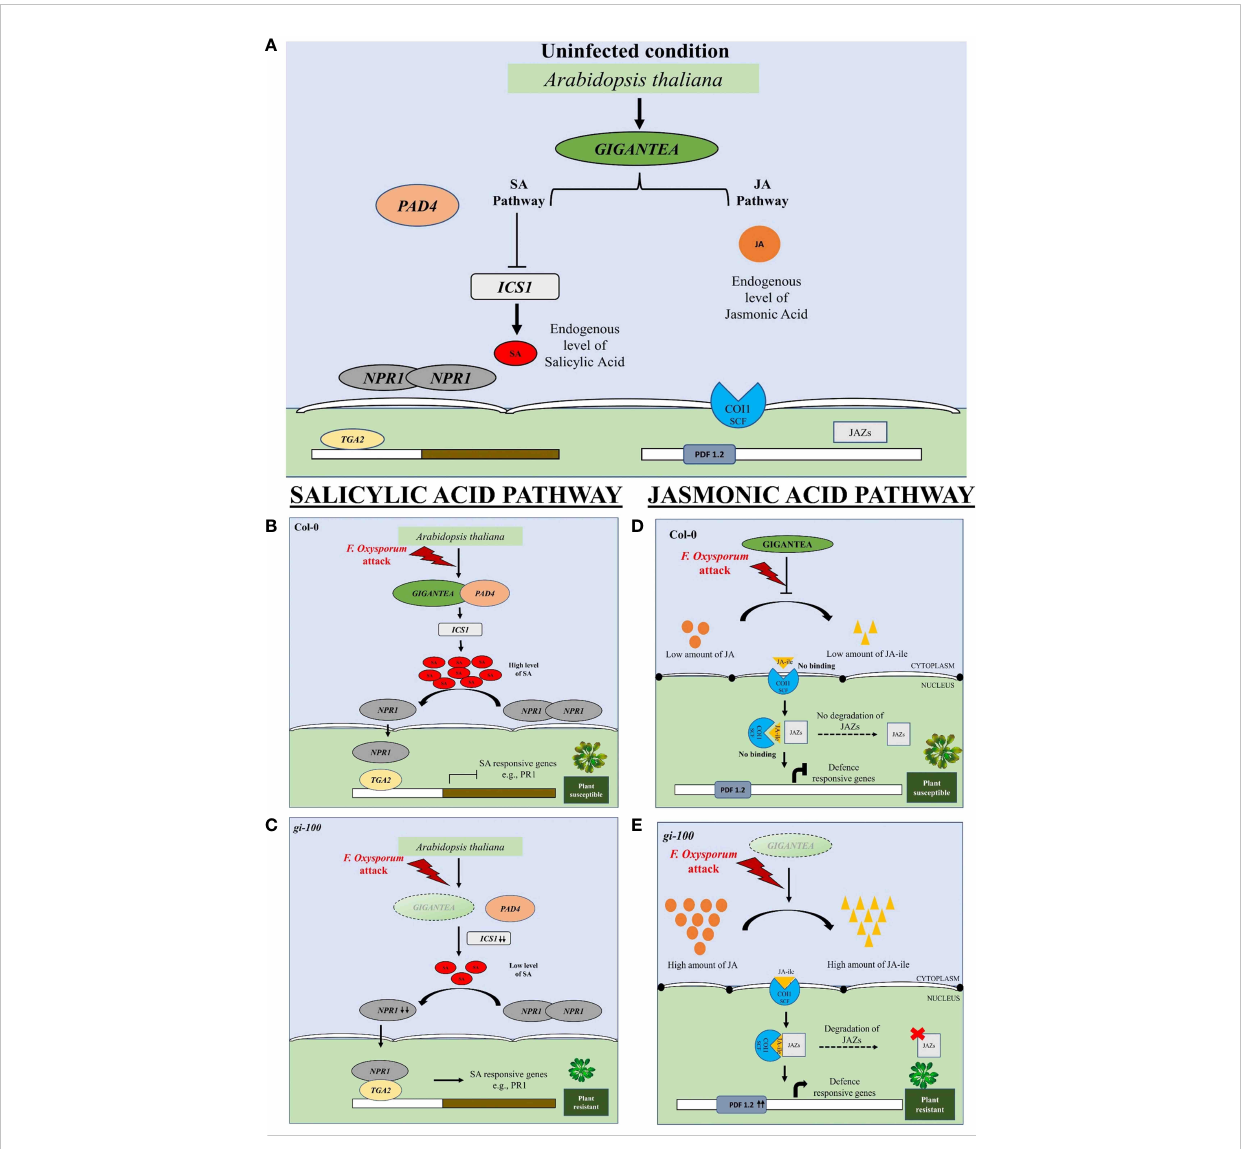
FIGURE 10 Diagrammatic representation of involvement of GIGENTEA, jasmonic acid, and salicylic acid pathway genes for eliciting pathogen response to F. oxysporum infection in Arabidopsis thaliana . (A) Under uninfected condition, jasmonic and salicylic acid levels and GI are at endogenous levels. The levels of ICS1 are low due to its inhibition. The dimerized form of NPR1 is unable to move into the nucleus and bind to any TF for defense response. Similarly, the JA pathway is also uninduced. (B) Salicylic acid pathway: When F. oxysporum infects wild-type Col-0 plants, increased GIGANTEA (GI) accumulation results in GI binding to PAD4, followed by increased SA accumulation. However, when infected, NPR1 is unable to bind to the transcription factor TGA2, limiting the expression of defense-related genes, i.e., PR1. (D) In the absence of GI, the SA pathway is reversed upon F. oxysporum infection, making the plant more resistant to the disease. (C) Jasmonic acid pathway: Increased GI expression and accumulation, on the other hand, results in less JA-ile in Col-0 (active form). Subsequently, there is a reduction in the transcript level of COI1 , which does not bind to JA- ile and thus cannot form a complex with JAZs. JAZs functions as a repressor, inhibiting PDF 1.2. This eventually makes the plant vulnerable to Fusarium infection. (E) On the contrary, in the absence of GI, the accumulation of JA-ile is high and it provides resistance to the plant upon F. oxysporum